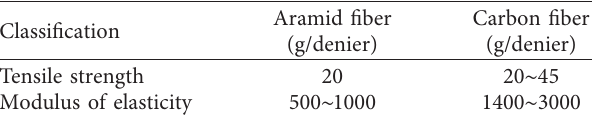
Table 1: Physical properties of general carbon fiber and aramid